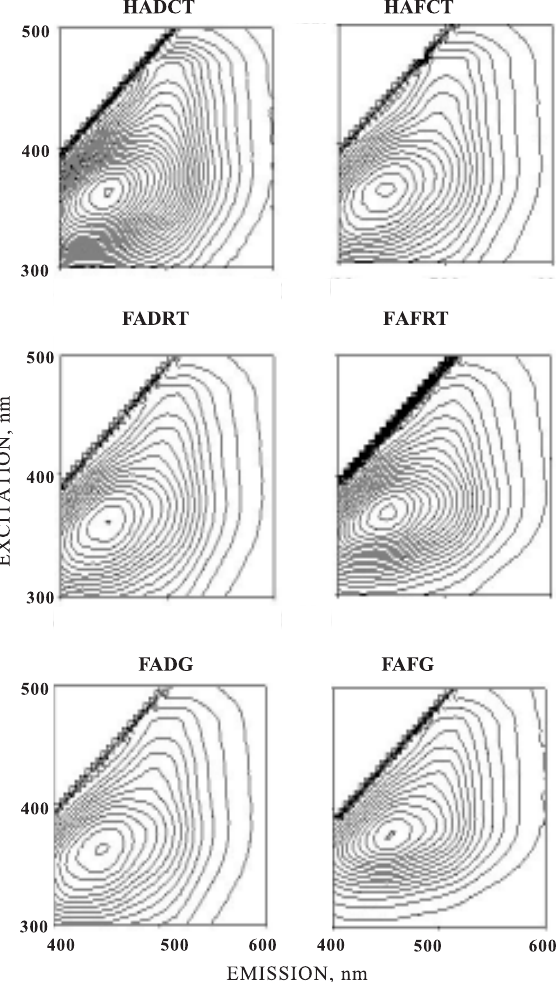
Figure 2. Total luminescence spectra of fulvic acids isolated from soil samples collected under drained *(FADCT, FADRT and FADG) and flooded conditions *(FAFCT, FAFRT and